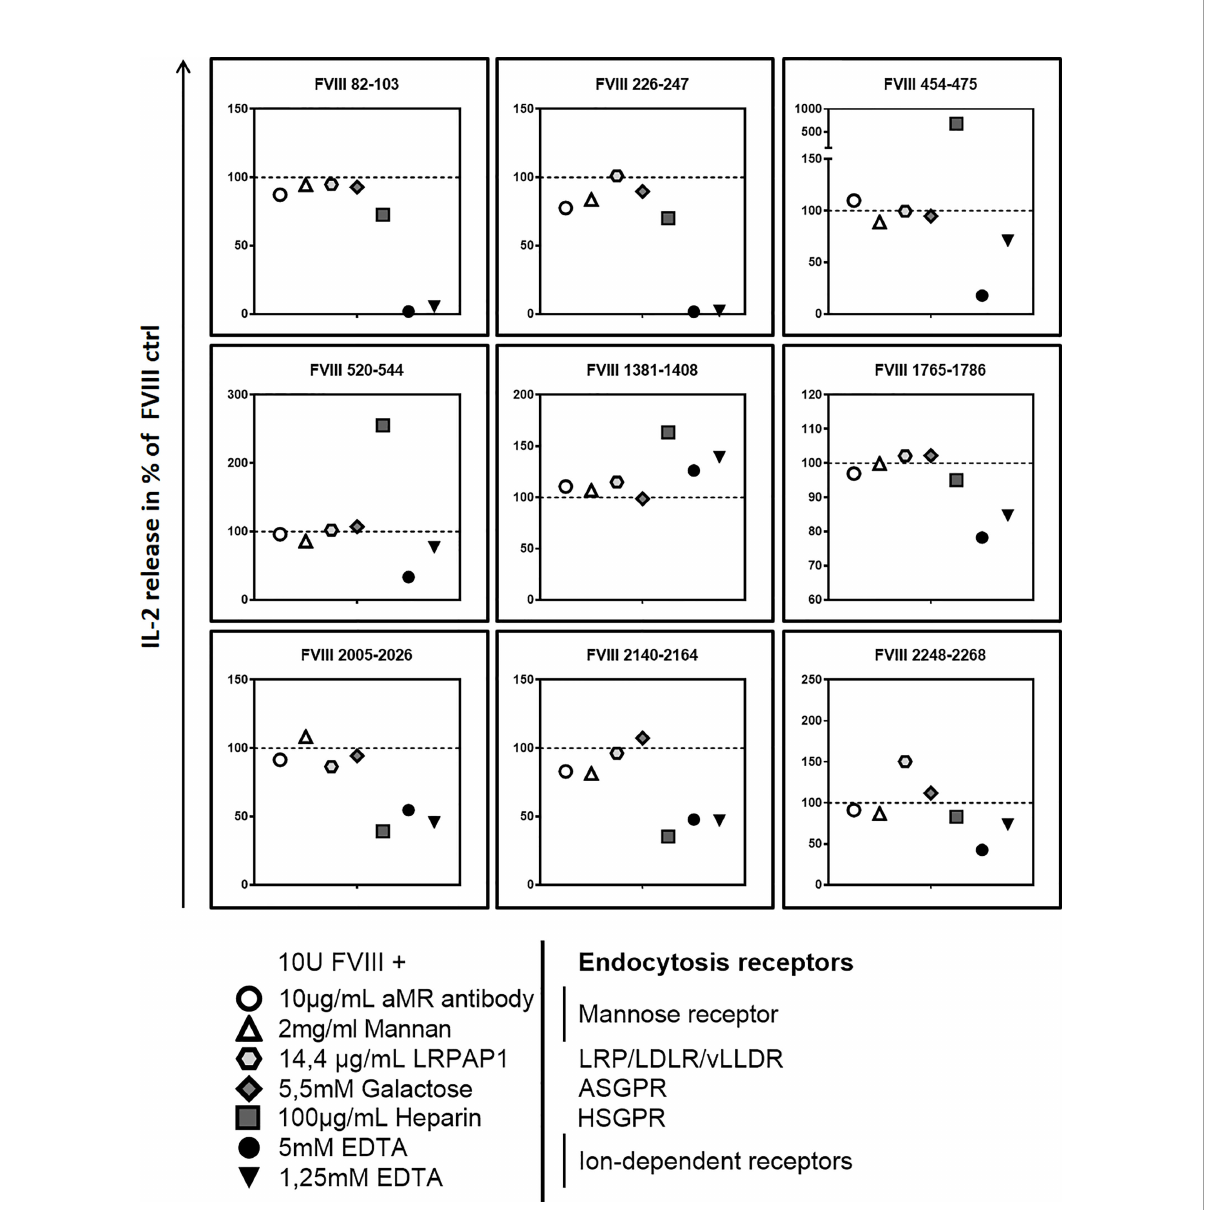
FIGURE 5 Blocking endocytosis receptors during preincubation of APCs modulates presentation of FVIII-derived peptides and subsequent stimulation of FVIII peptide-speci fi c CD4+ T cells hybridoma clones. APCs were preincubated with speci fi c blocking agents for endocytosis receptors which are associated with the endocytosis of FVIII: 5mM Galactose to block the asialoglycoprotein receptors (ASGPR); 100µg/mL Heparin to block heparan sulfate proteoglycans (HSGP), 2mg/mL Mannan or 10µg/mL of a speci fi c monoclonal antibody to block the Mannose Receptor, 14.4 µg/mL recombinant mouse LRPAP1 to block the low-density lipoprotein receptor – related protein-1 (LRP1), 1.25mM and 5mM EDTA to inhibit the function of bivalent ion-dependent receptors. After 3hrs incubation, APCs were washed and subsequently cocultured with FVIII speci fi c CD4 + T cell hybridoma clones covering the 9 CD4 T-cell epitopes recognized by the hybridoma library. Relative IL-2 release as an indicator for the activation of hybridoma clones in relation to the normal FVIII control (100%) is presented. Depicted is the mean value derived from 2 independent experiments done in triplicates (n=6). Detailed data and statistical analysis are depicted in Table